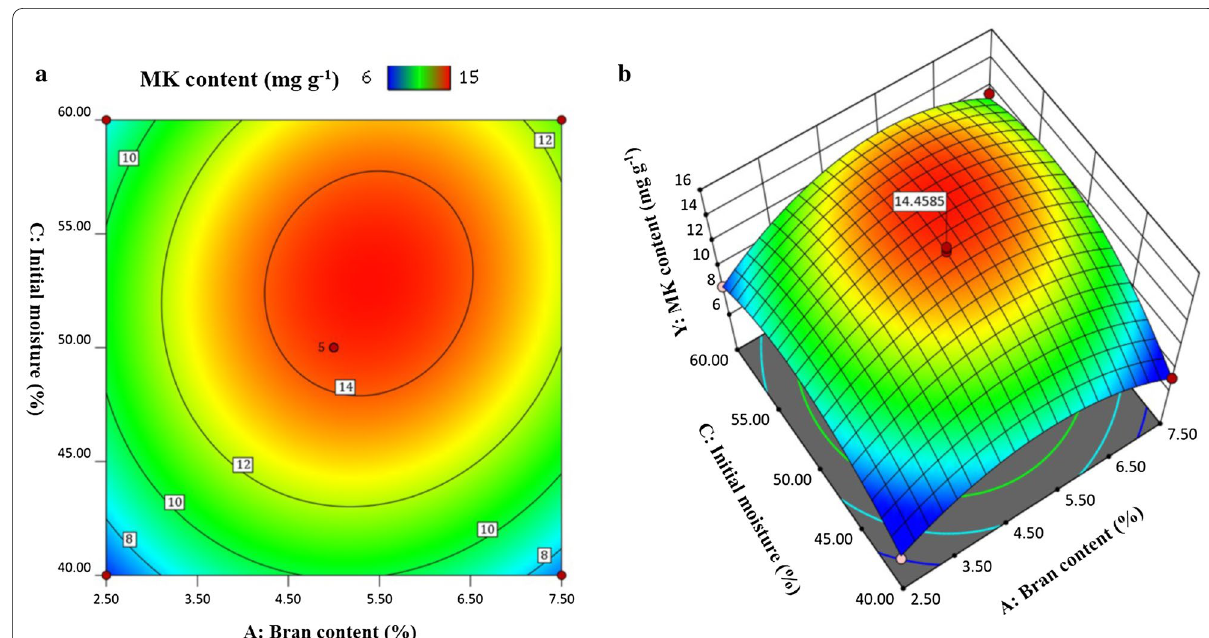
Fig. 7 Interaction between bran content and initial moisture at a fixed media amount of 60 g: (a) Contour plot and (b) 3D Surface